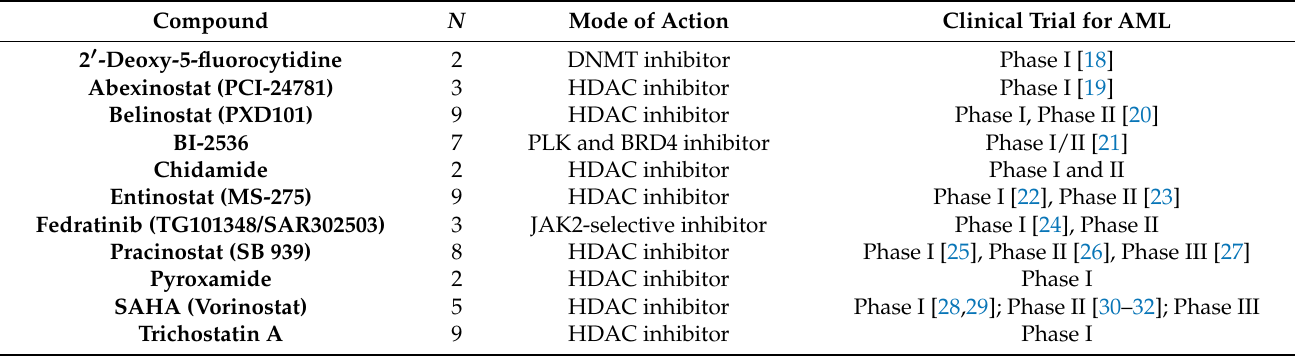
Table 3. Efficacious epigenetic compounds in clinical evaluation for AML.